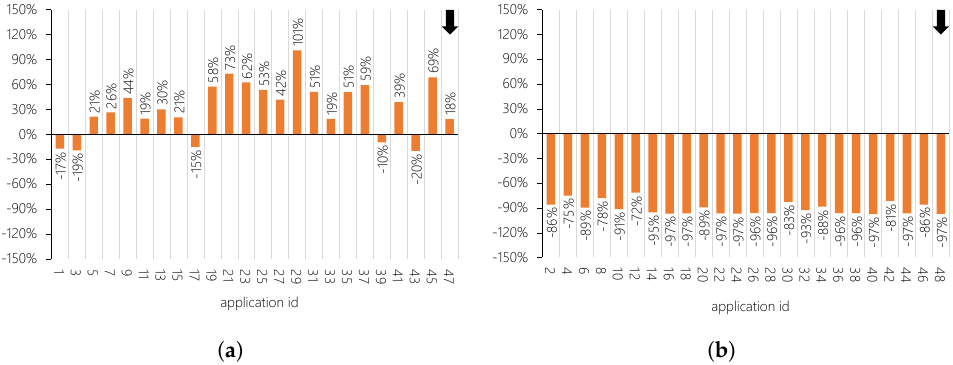
Figure 8. Variation in the average jitter of each application. The figures represent the results for the applications that consume depth data ( a ) and position data ( b ). The black arrow represents the direction for better